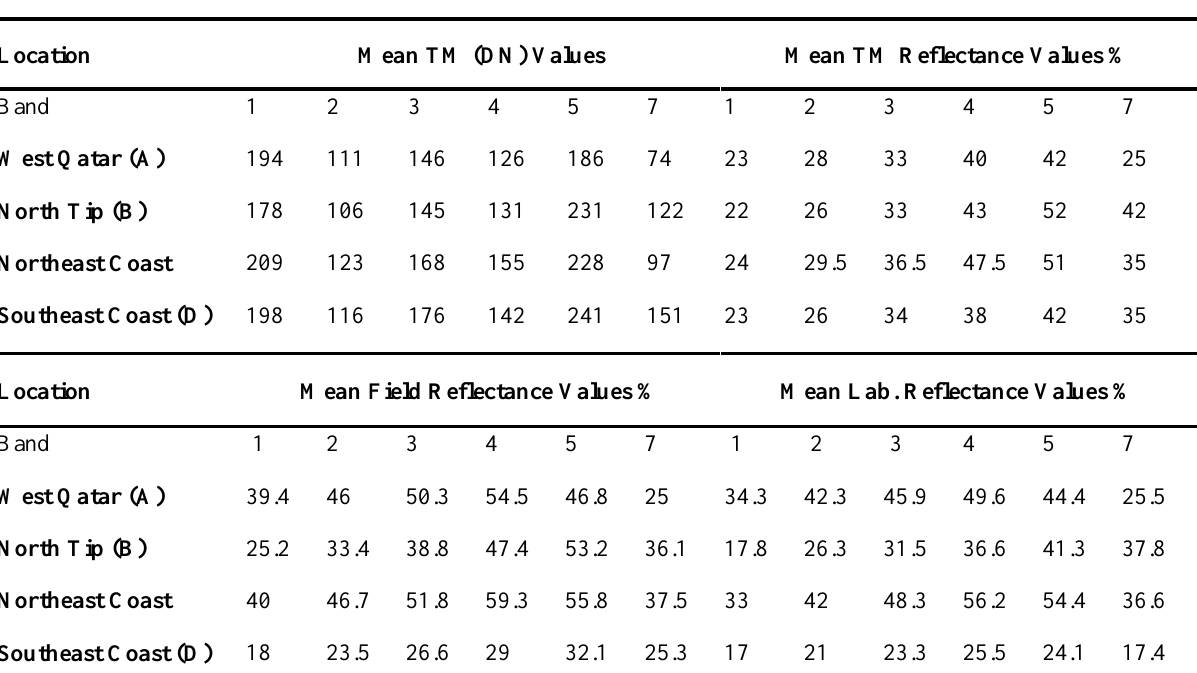
Table 5. Digital number (DN) values, and mean TM, field and laboratory reflectance values of west, north, northeast and southeast parts of Qatar